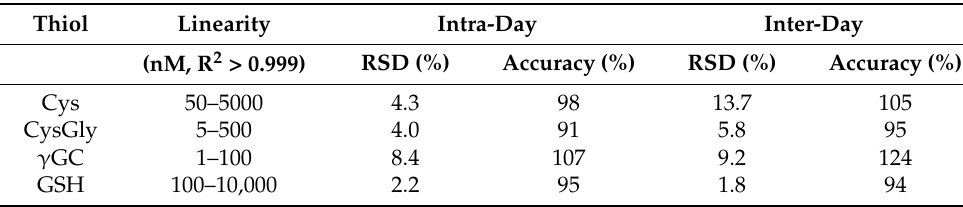
Table 1. Validation data of the developed